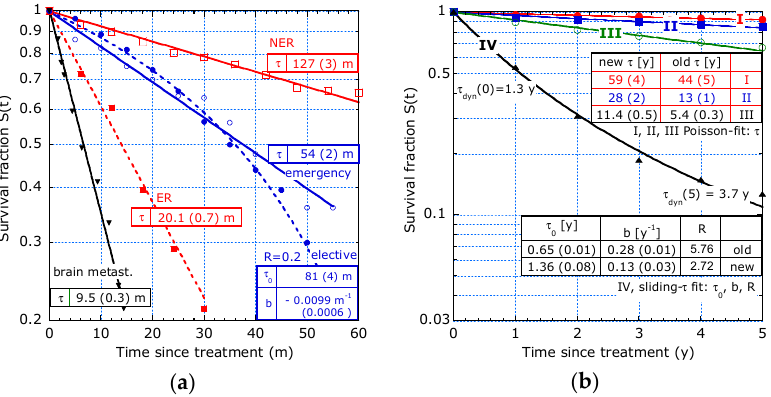
Figure 10. Smoothening of KM curves for studies on small populations and comparison between time period: ( a ) CRS + HIPEC study on elective (blue dots) and emergency (blue circles) patients from Figure 2 in [12], early recurrence (ER, red full squares) and non-early recurrence (NER, red open squares) from Figure 1 in [13], survival from brain metastases from Figure 2 in [14] (black triangles); ( b ) Time period study on CRC with stages I, II and III fit the Poisson model; stage IV fits the sliding- τ model, only period 2010–2014 (new) is shown, based on Figure 2a–d in [15] and period 1989–1994 (old) is compared with ‘new’ in the two